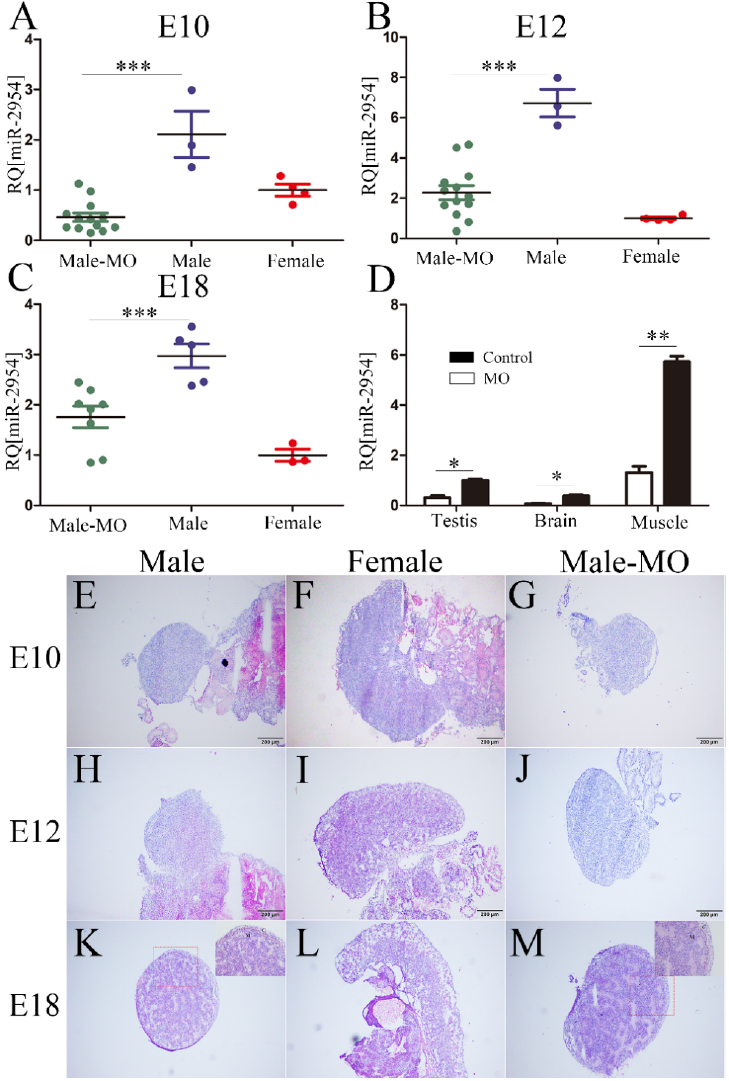
Figure 4. The expression of miR-2954 and HE staining of chicken embryonic gonads after VMO-miRNA-2954 treatment. ( A – C ) The expression of miR-2954 in chicken gonads after VMO-miR-2954 treatment at E10, E12, and E18, respectively. ( D ) The expression level of miR-2954 in different tissues of males at E12 after VMO-miR-2954 treatment. MO, VMO-miR-2954; M, male; F, female. Error bars show standard deviation (SEM). Asterisks indicate statistical significance: * p < 0.05, ** p < 0.01, *** p < 0.0001. ( E – G ) Embryonic gonadal histomorphology at E10 stage in male, female, and VMO-treated male, respectively. ( H – J ) Embryonic gonadal histomorphology at E12 stage in male, female, and VMO-treated male, respectively. ( K – M ) Embryonic gonadal histomorphology at E18 stage in male, female, and VMO-treated male, respectively. C, cortex; M. medulla. For all pictures, scale bar = 200 μ m, thickness = 6 μ m.